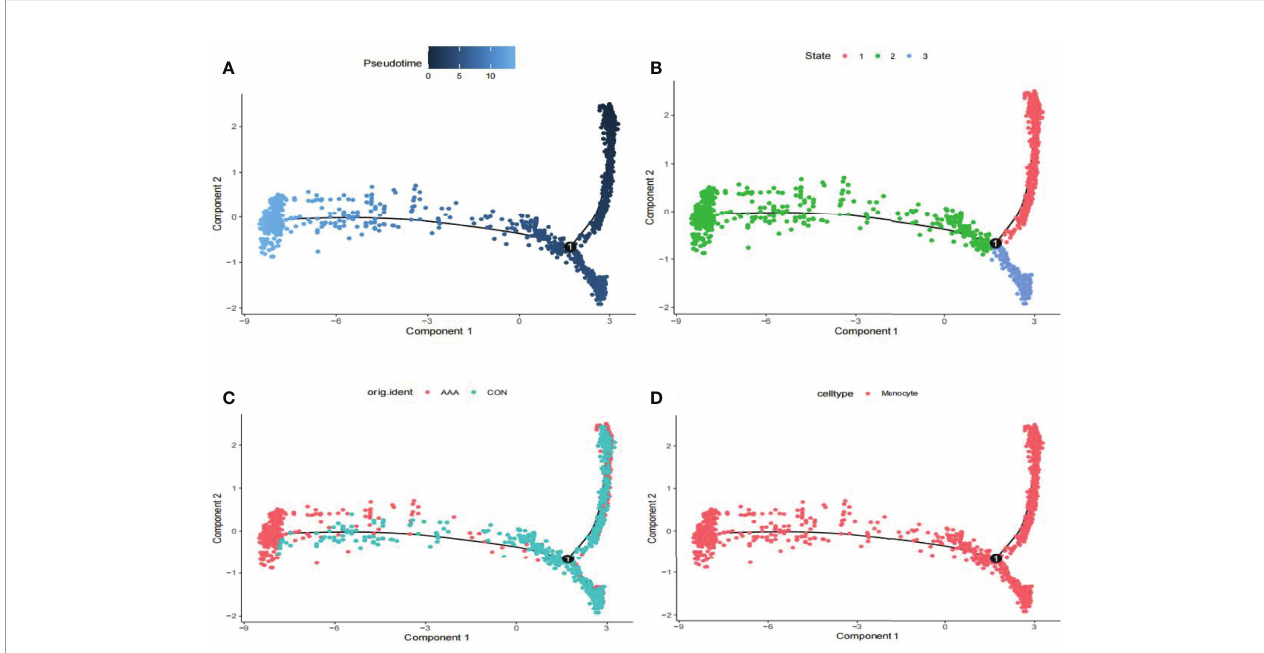
FIGURE 3 | Analyses of pseudotime in GSE166676. (A) Timing differences in cell differentiation. Darker blue represents an earlier stage of differentiation, while a lighter blue indicates a later stage of differentiation. This serves as a starting point for subsequent analysis. (B) Three stages of monocyte differentiation. State 1 is the earliest stage of differentiation. (C) Differentiation of AAA monocytes from normal monocytes. (D) All cells analyzed were monocytes. AAA, abdominal aortic